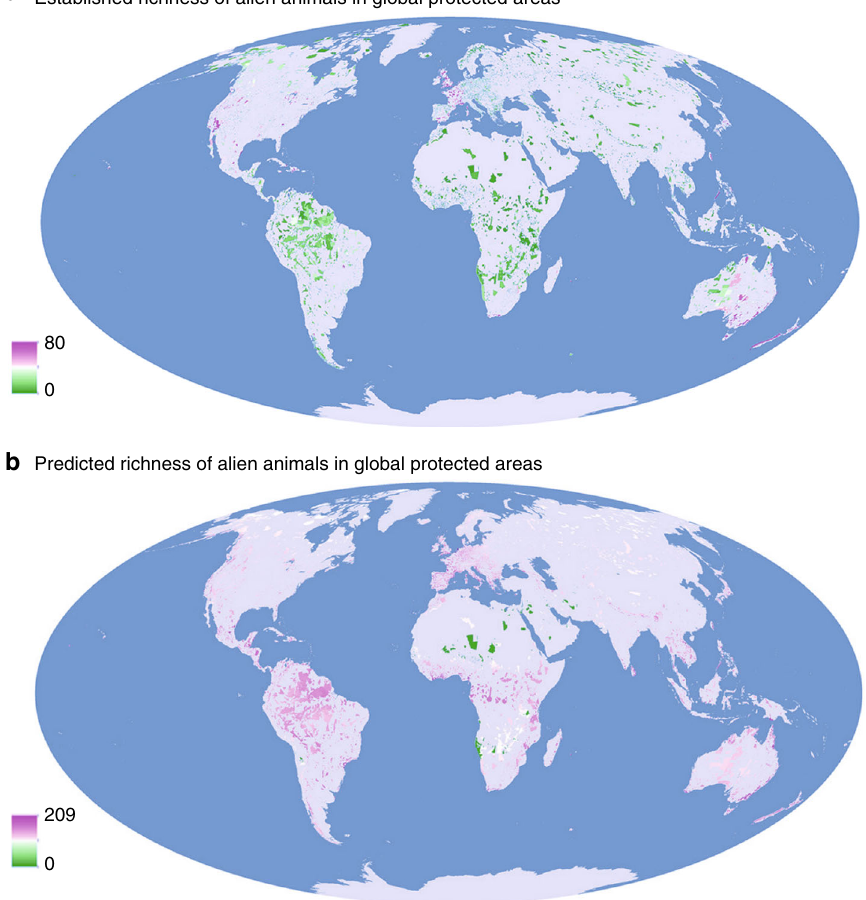
Fig. 1 Established and predicted richness of 894 alien animals in 199,957 global terrestrial Protected Areas. Richness was calculated as the total number of species across 11 taxa (Amphibia, Reptilia, Aves and Mammalia, Arachnida, Branchiopoda, Chilopoda, Diplopoda, Malacostraca, Gastropoda and Insecta) established in each protected area. The predicted richness of alien species was determined using species distribution models (SDMs) based on an ensemble of fi ve widely used powerful algorithms. SDMs fi t correlative models to alien animal distributions and environmental niches from native and invaded ranges, and then identify the most suitable habitats in PAs.